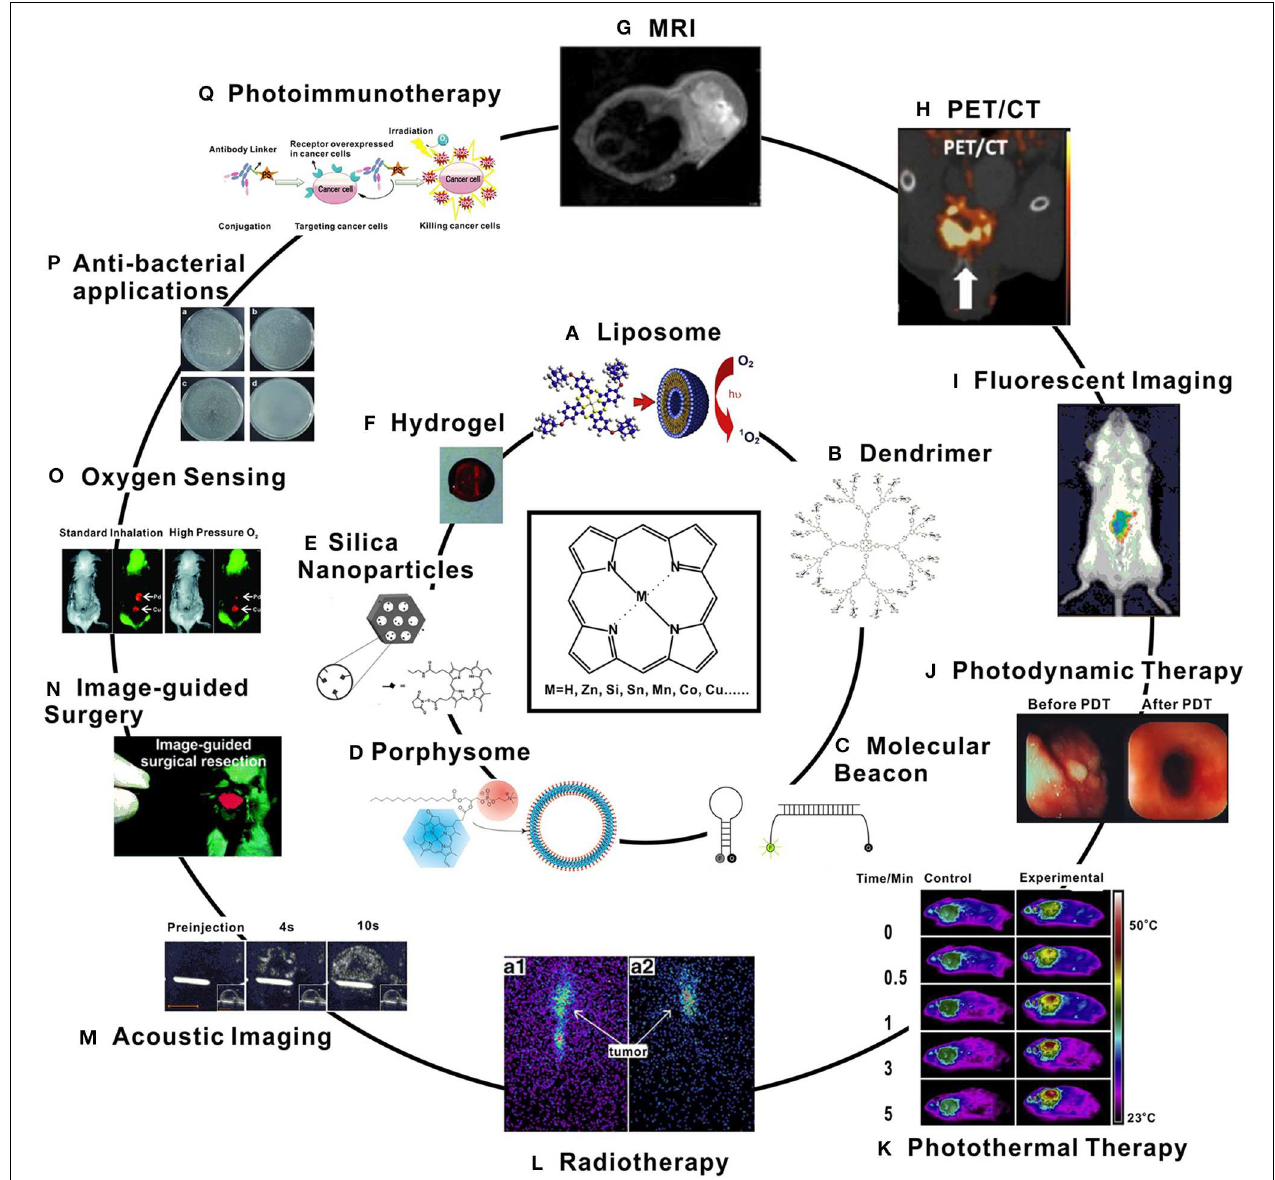
(K) Thermal images of tumor-bearing mice with Pc-loaded nanoparticles exposed to a NIR laser [18]; (L) 8h (a1) and 24h (a2) radioimaging of melanoma-bearing mice after injection with 188 Re-T 3 , 4 CPP [1]; (M) Acoustic images of a tumor-bearing mouse after injection with porphyrin-shell microbubbles [19]; (N) Image-guided surgery with a porphyrin-PEG cross-linked hydrogel [20]; (O) Phosphorescence images of an implanted Pd-porphyrin hydrogel in mice breathing different oxygen levels [13]; (P) Photoirradiation of bacteria under various photosensitizer conditions [21]; (Q) Photoimmunotherapy concept [22]. All figures used with permission from the indicated